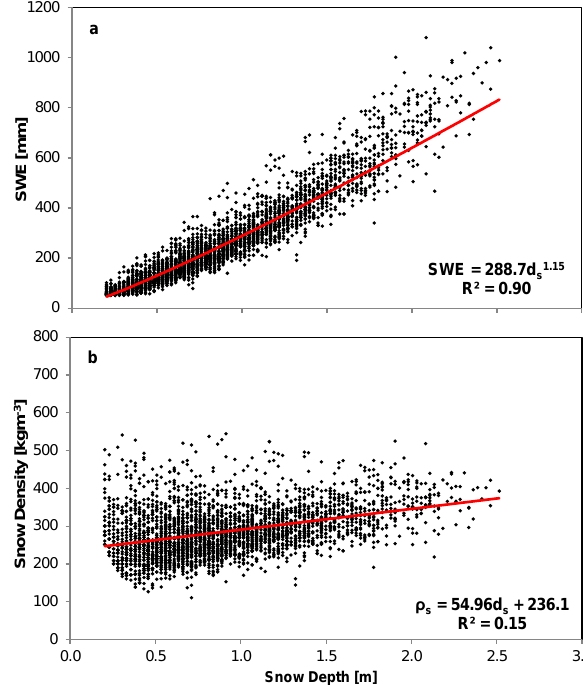
Fig. 3. Pairwise relations of SWE and snow density with snow depth from historic snow course measurements within the study